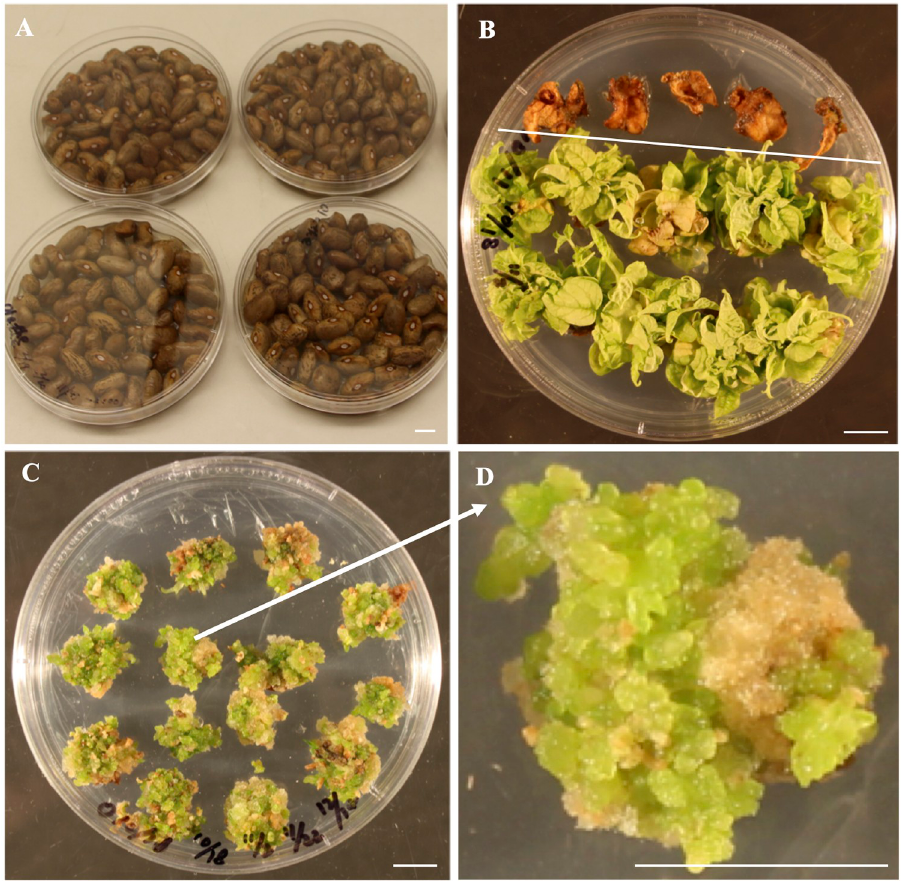
Fig 2. Induction of competent cells from embryo axes for efficient regeneration of ‘Olathe’ pinto bean. (A) Surface sterilized and soaked seeds for explant preparation. (B) Shoot production from embryo axes after 4-week culture on RM1, on which leaf explants did not survive. A . tumefaciens -mediated transformation of ‘Olathe’ pinto bean. (C, D) Embryo axes after 12-week preculture on RM. All shoots were removed during the subcultures in order to promote callus and bud formation. Bars = 1